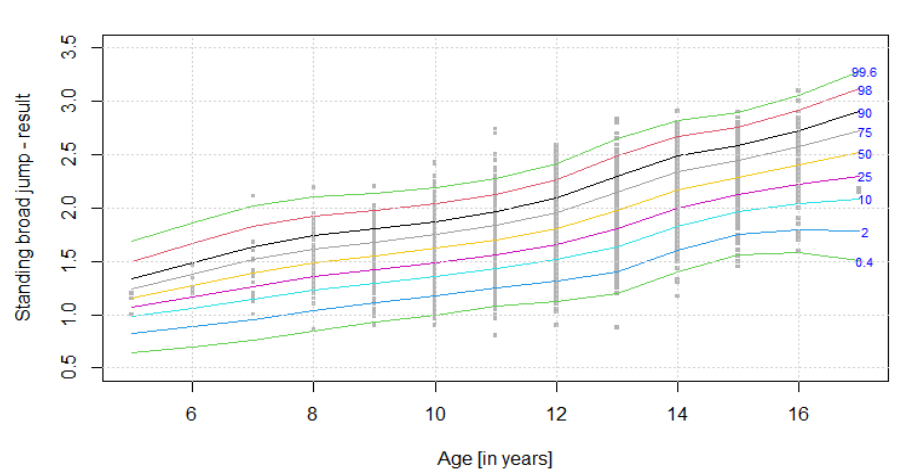
Figure 3. Centile chart for standing broad jump in boys. Table 6. Values of particular centiles for standing broad jump in boys.